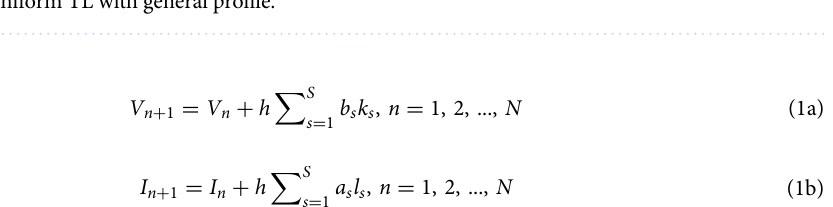
Figure 1. A non-uniform TL with general